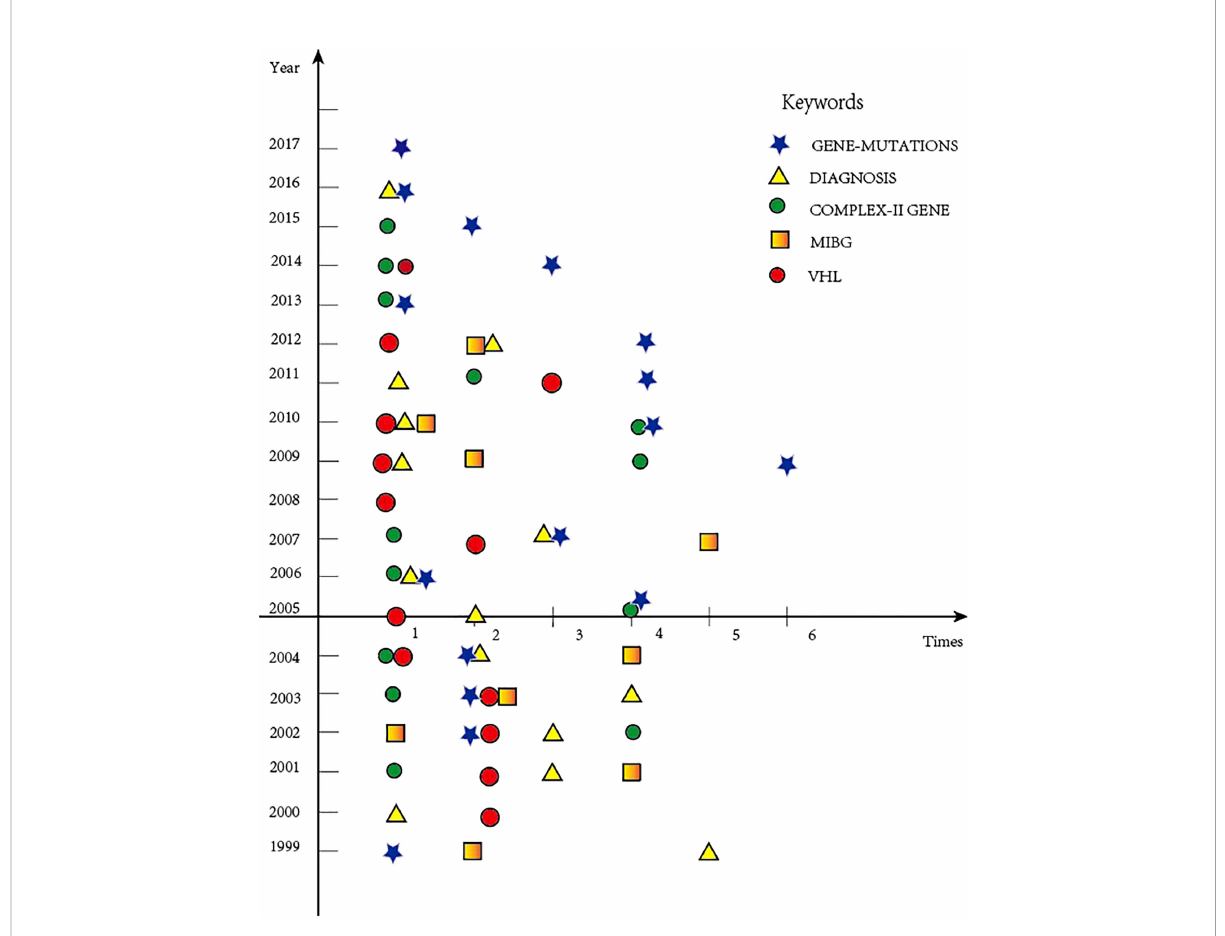
FIGURE 3 The relationship between top 5 keywords and